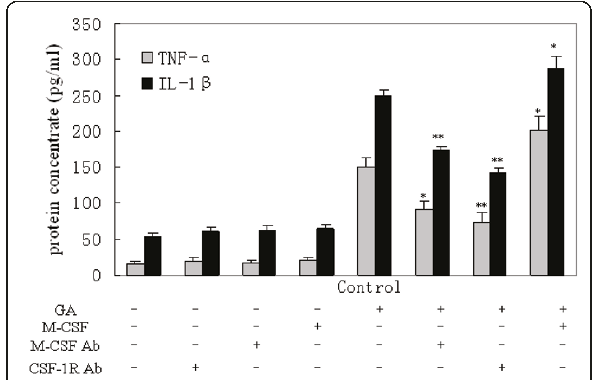
Figure 9 Release of TNF- a and IL-1 b from microglia following the neutralization of M-CSF or CSF-1R, or the administration of M-CSF . None of the above had a significant effect on cytokine release in the groups without glycated albumin (GA) stimulation. The neutralization of M-CSF (1 μ g/mL) or CSF-1R (1 μ g/mL) suppressed TNF- a and IL-1 b release in the experimental group (cells treated with 250 μ g/mL GA for 24 h). Treatment with 100ng/mL M- CSF augmented the GA-induced release of TNF- a and IL-1 b . One- way ANOVA was performed, followed by post-hoc analysis. *, P < 0.05; **, P < 0.001, compared with the control